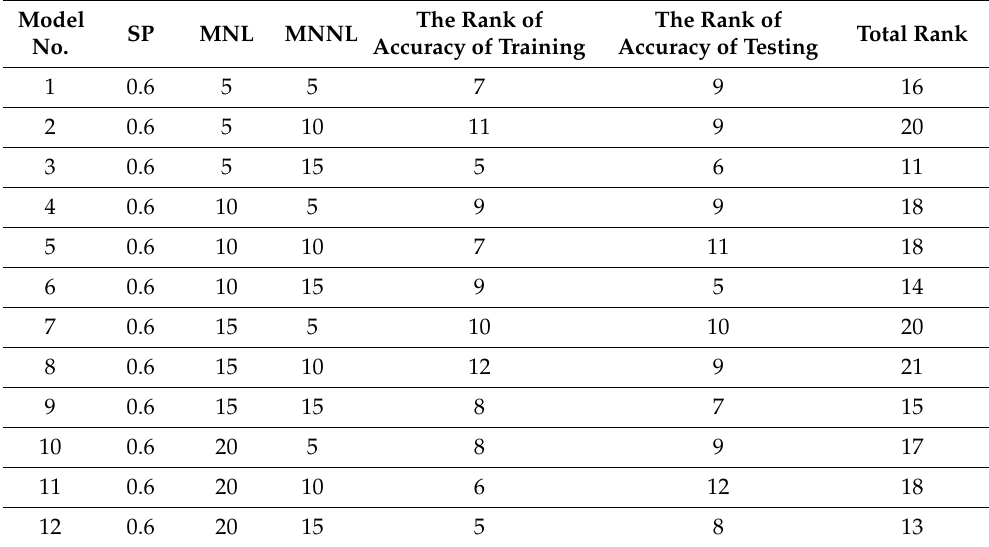
Table 3. Ranking developed binary classification models.